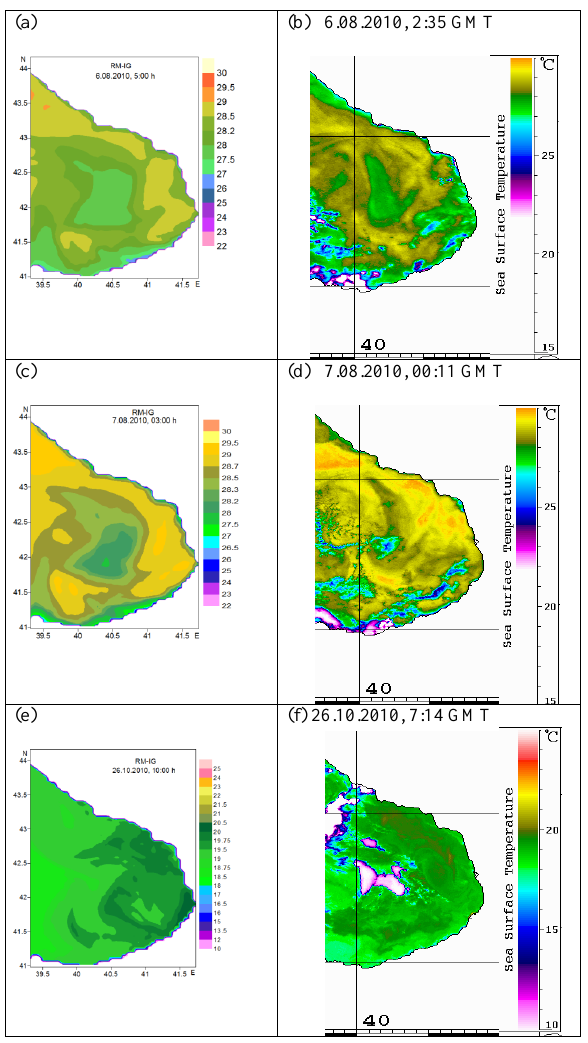
Fig. 1. Forecasted (on the left side) and satellite SST derived from NOAA (on the right side).